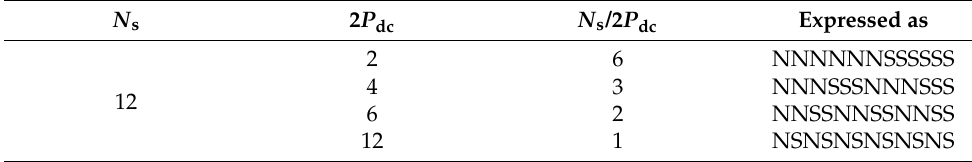
Table 1. Configurations of DC Component Pole Pairs.